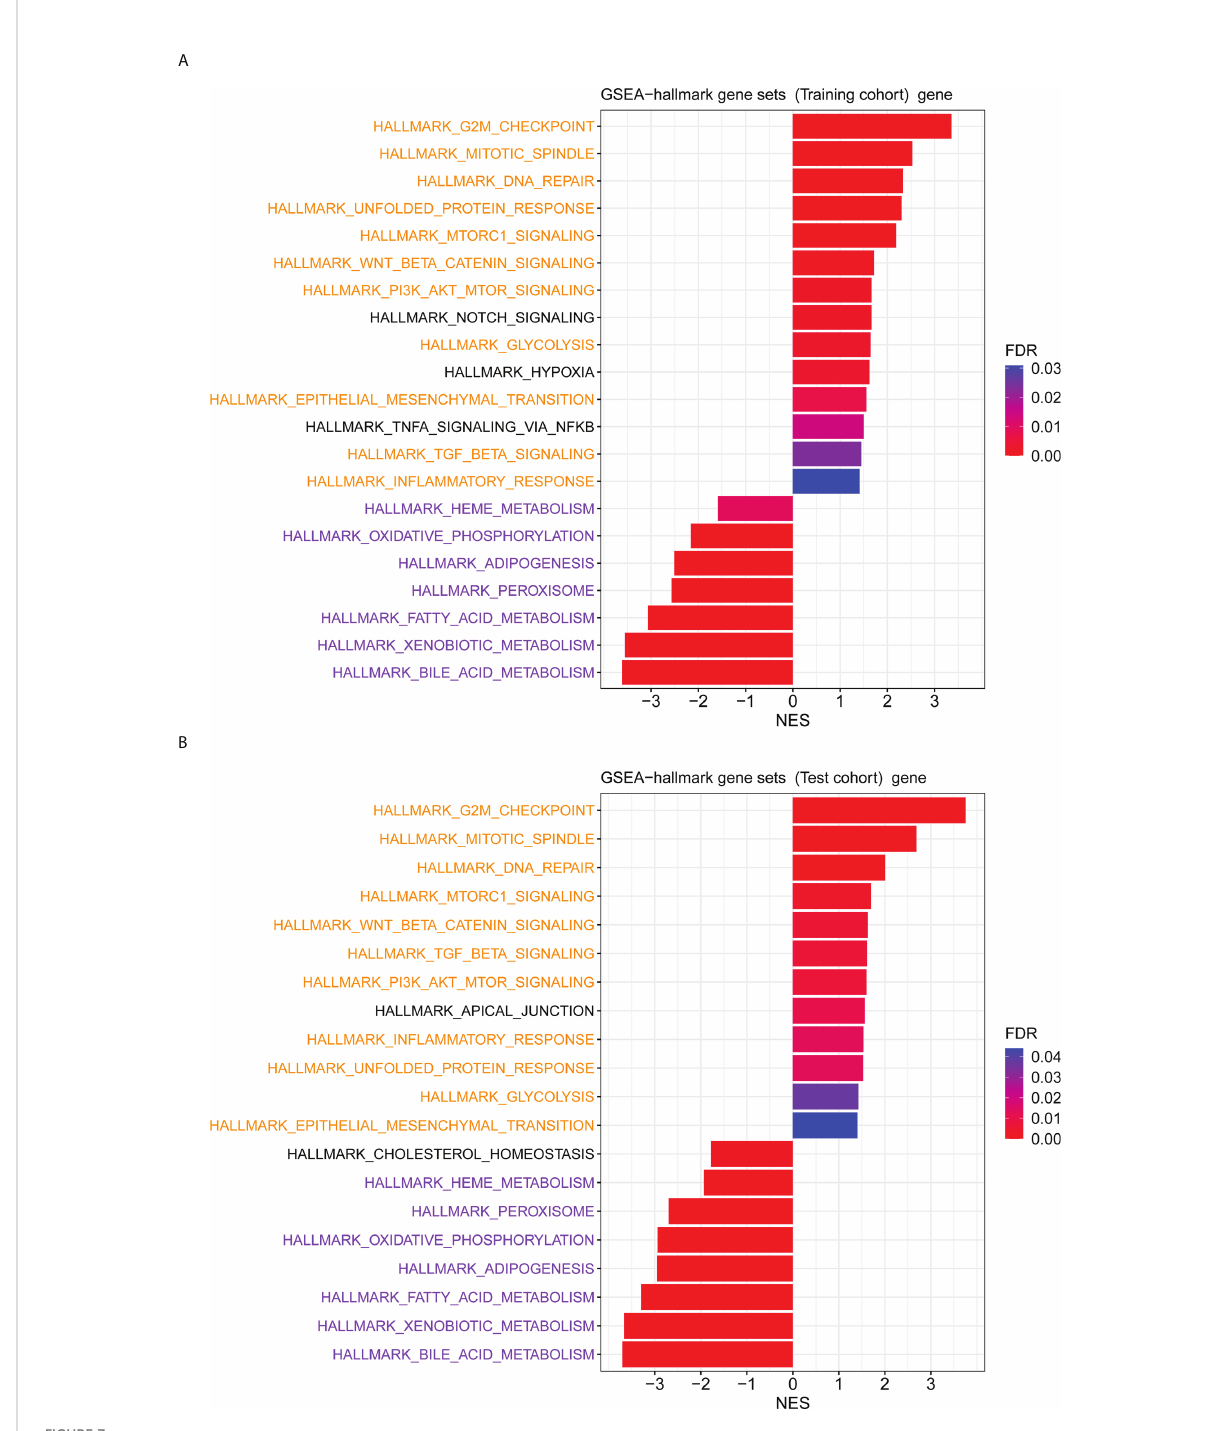
FIGURE 7 The GSEA analysis for genes between the high- and low-risk groups. (A) The hallmark pathways that were signi fi cantly enriched in the high- and low-risk groups based on the transcriptome data in the training cohort. (B) The hallmark pathways were signi fi cantly enriched in the high- and low-risk groups based on the transcriptome data in the test cohort. Pathways marked in yellow are some pathways that were both enriched in the high-risk group of training and test cohorts, and pathways marked in purple are some pathways that were both enriched in the low-risk group of training and test